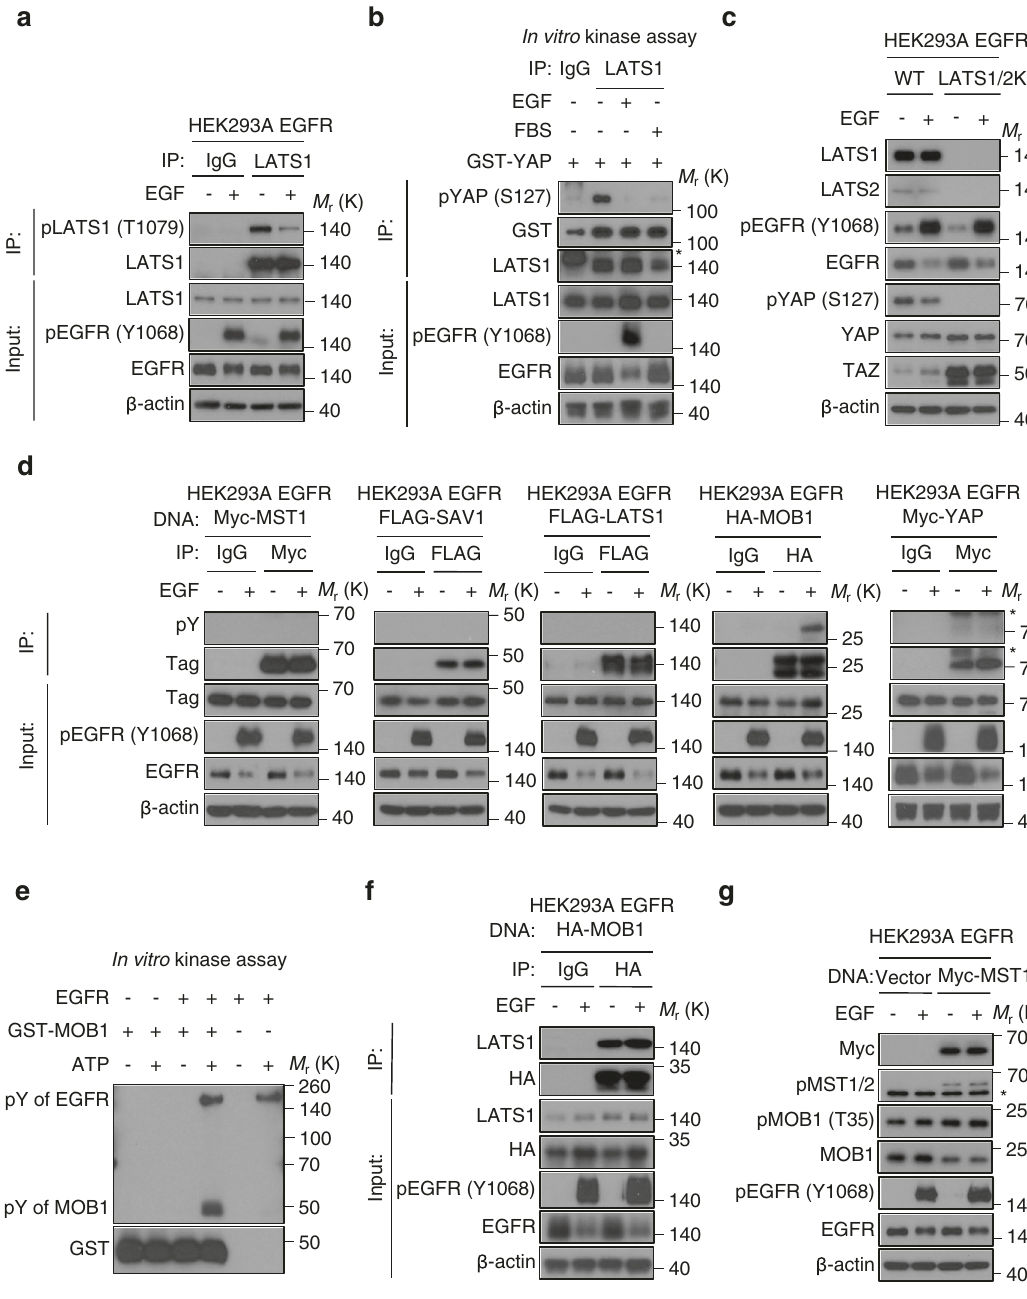
Fig. 3 EGFR stimulation leads to MOB1 phosphorylation and LATS1/2 inactivation, independently of MST1/2. a Immunoprecipitation of LATS1. Lysates were immunoprecipitated with control IgG or an antibody against LATS1. Immunoblot of pLATS1 (T1079), LATS1, pEGFR (Y1068), EGFR, β -actin in EGFR- overexpressing HEK293A cells. Cells were serum stared for 16h, and treated with EGF (20ng/ml) for 1h. b In vitro kinase assay of LATS1 against YAP. Lysates were immunoprecipitated with control IgG or an antibody against LATS1, then applied for in vitro kinase reaction with GST-YAP protein. Cells were serum starved for 16h, and treated with EGF (20ng/ml) or FBS (10%) as positive control for 1h. Immunoblot of pYAP (S127), GST, LATS1, pEGFR (Y1068), EGFR, β -actin. Arrow indicates non-speci fi c band. c Immunoblot of LATS1, LATS2, pEGFR (Y1068), EGFR, pYAP (S127), YAP, TAZ, β -actin in WT, or LATS1/2 KO HEK293A cells. WT or LATS1/2 KO HEK293A cells were transfected with EGFR plasmid and incubated for 24h, serum starved for 16h, and treated with EGF (20ng/ml) for 1h. d Immunoprecipitation of Myc-MST1, FLAG-SAV1, FLAG-LATS1, HA-MOB1, and Myc-YAP. Lysates were immunoprecipitated with control IgG or antibodies against each Tag. Immunoblot of pY, Tag, pEGFR (Y1068), EGFR, β -actin. EGFR-overexpressing HEK293A cells were transfected with the Hippo-components and YAP plasmid, incubated for 24h, serum starved for 16h, and treated with EGF (20ng/ml) for 1h. e In vitro kinase assay of EGFR and GST-MOB1. In vitro kinase reaction was performed with recombinant EGFR, GST-MOB1 protein, and ATP. Immunoblot for pY and GST. f Co-immunoprecipitation of HA-MOB1 and LATS1. Lysates were immunoprecipitated with control IgG or an antibody against HA-tag. Immunoblot of LATS1, HA, pEGFR (Y1068), EGFR, β -actin. EGFR-overexpressing HEK293A cells were transfected with HA-MOB1 plasmid and incubated for 24h, serum starved for 16h, and treated with EGF (20ng/ml) for 1h. g Immunoblot of Myc-tag, pMST1/2 (T183/T180), pMOB1 (T35), MOB1, pEGFR (Y1068), EGFR, β -actin. EGFR-overexpressing HEK293A cells were transfected with vector or Myc- MST1 plasmid and incubated for 24h, serum starved for 16h, and treated with EGF (20ng/ml) for 1h. Asterisks indicate non-speci fi c